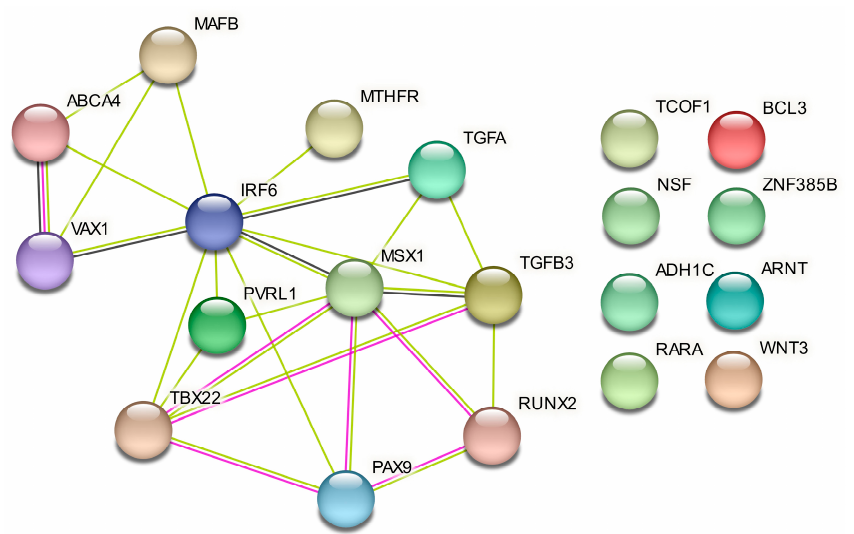
Figure 2. Protein–protein interaction network of 20 candidate genes for NSCL/P. Green line, the presence of co-publications in text mining; purple line, experimental evidence of co-expression; black line, evidence of mRNA co-expression (based on a STRING confidence score of 0.45).